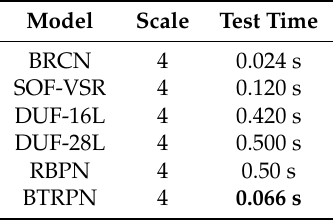
Table 9. Test time compared to other models for a frame on the calendar